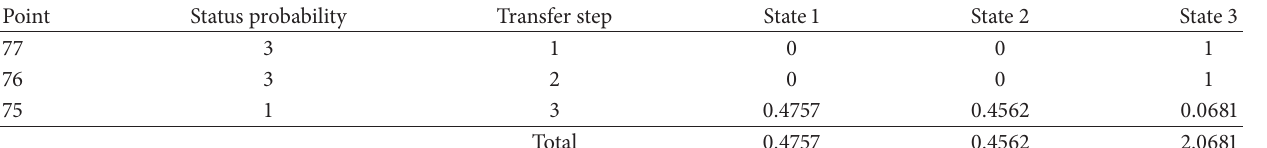
Table 3: Table of the probability status.